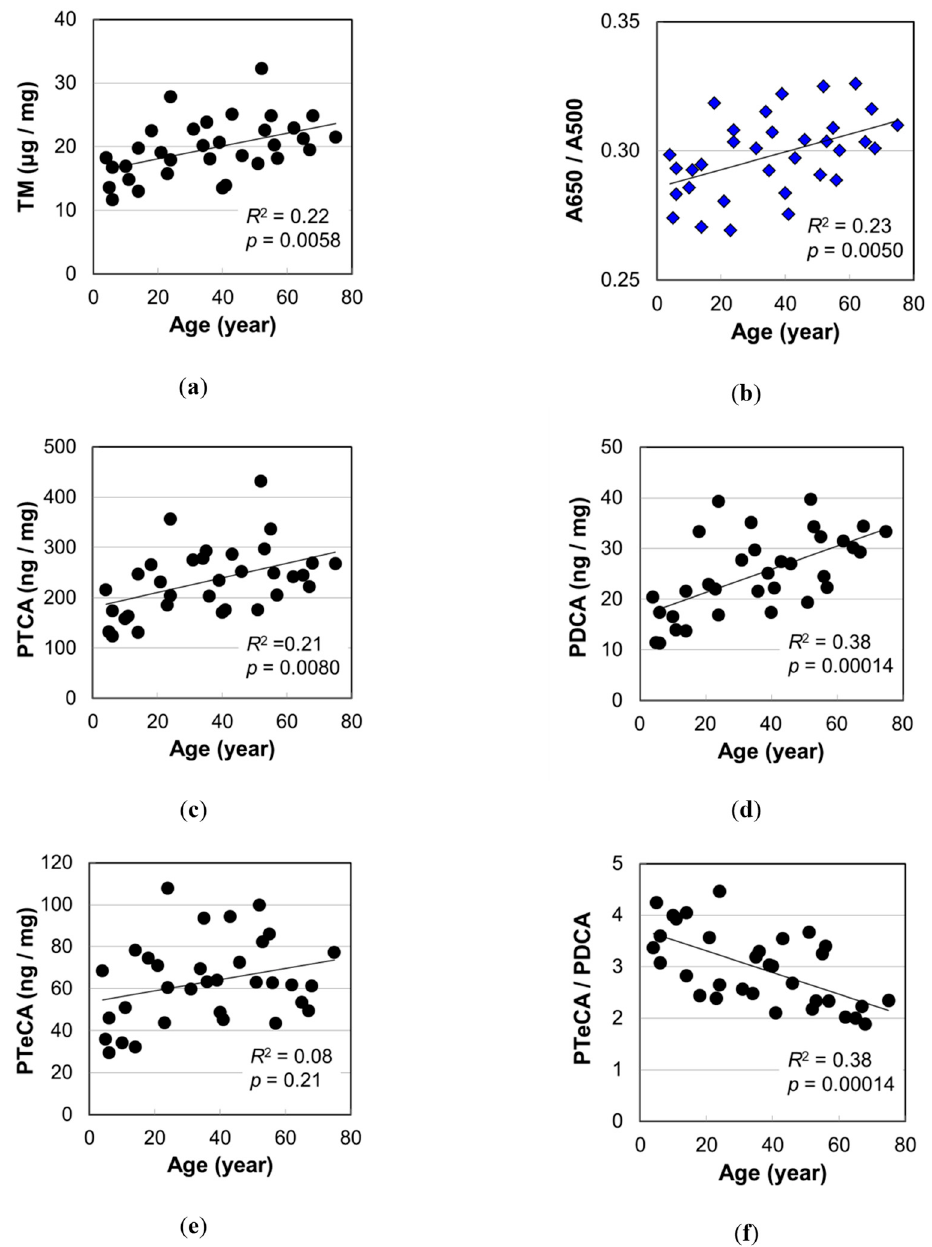
Figure 3. The age dependencies of various values measured by melanin analyses of Japanese female hairs. ( a ) Total melanin amount (TM). ( b ) Absorbance ratio A650/A500 for Soluene-350 solution of hair melanin. ( c ) Level of pyrrole-2,3,5-tricarboxylic acid (PTCA) in hair. ( d ) Level of pyrrole-2,3-dicarboxylic acid (PDCA) in hair. ( e ) Level of pyrrole-2,3,4,5-tetracarboxylic acid (PTeCA) in hair. ( f ) The